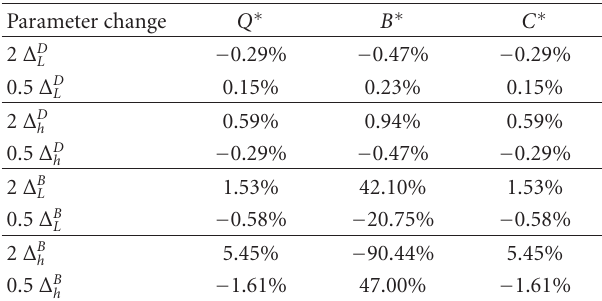
Table 1: The result from the example calculations. Table 2: The results from the sensitivity analysis, that is, the changes in the fuzzy solution values, given some changes in the fuzzy parameters Δ B and Δ D